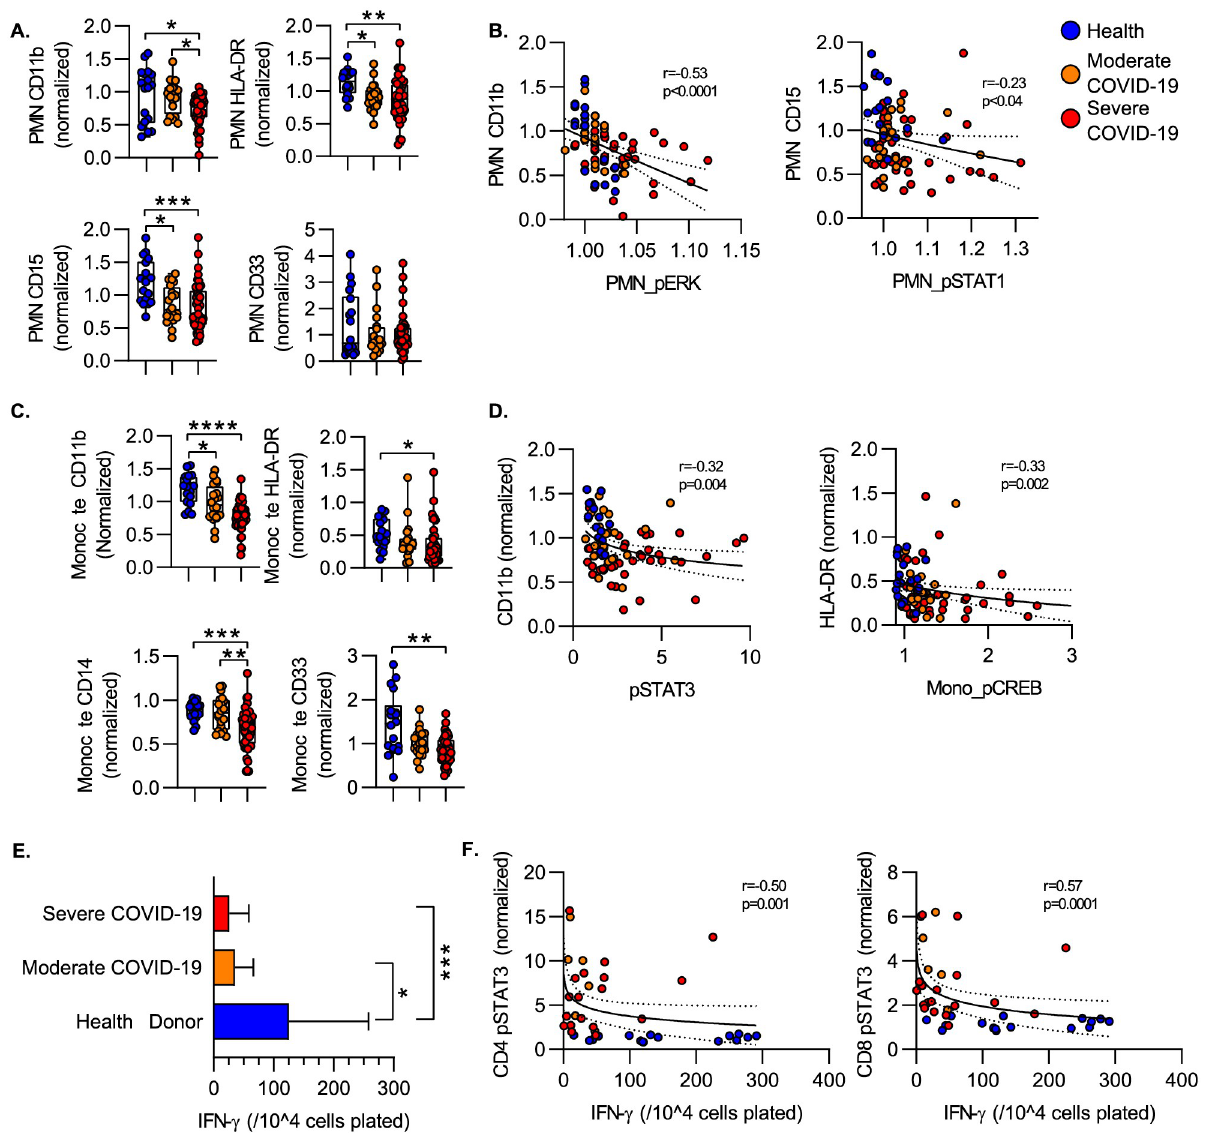
Fig 6. Activation markers and cytokine production. A) Levels of surface marker expression on circulating neutrophils. B) Correlation between neutrophil surface marker expression level and intracellular phosphoprotein levels. C) Levels of surface marker expression on circulating neutrophils. D) Correlation between neutrophil surface marker expression level and intracellular phosphoprotein levels. E) IFN- γ production measured by ELISpot. PBMC were stimulated with CD3/CD28 antibodies and the number of IFN- γ producing cells enumerated. Bars show median spot number/ 10 4 cells +/- interquartile range. F) Correlation between ELIspot IFN- γ production and intracellular phosphoprotein expression. Correlation plots display results from Spearman correlation test and semilog regression curve (solid line) with 95% confidence intervals (dotted lines).). Box plots represent 25-75 th percentile with line defining group median, with all data-points overlying. Error bars extend from minimum to maximum values. � p < 0.05, �� p < 0.01, ��� p < 0.001, ���� p < 0.0001 by Dunn’s multiple comparisons test after nonparametric (Kruskal-Wallis) ANOVA with correction for FDR < 1% (Benjamini, Krieger and